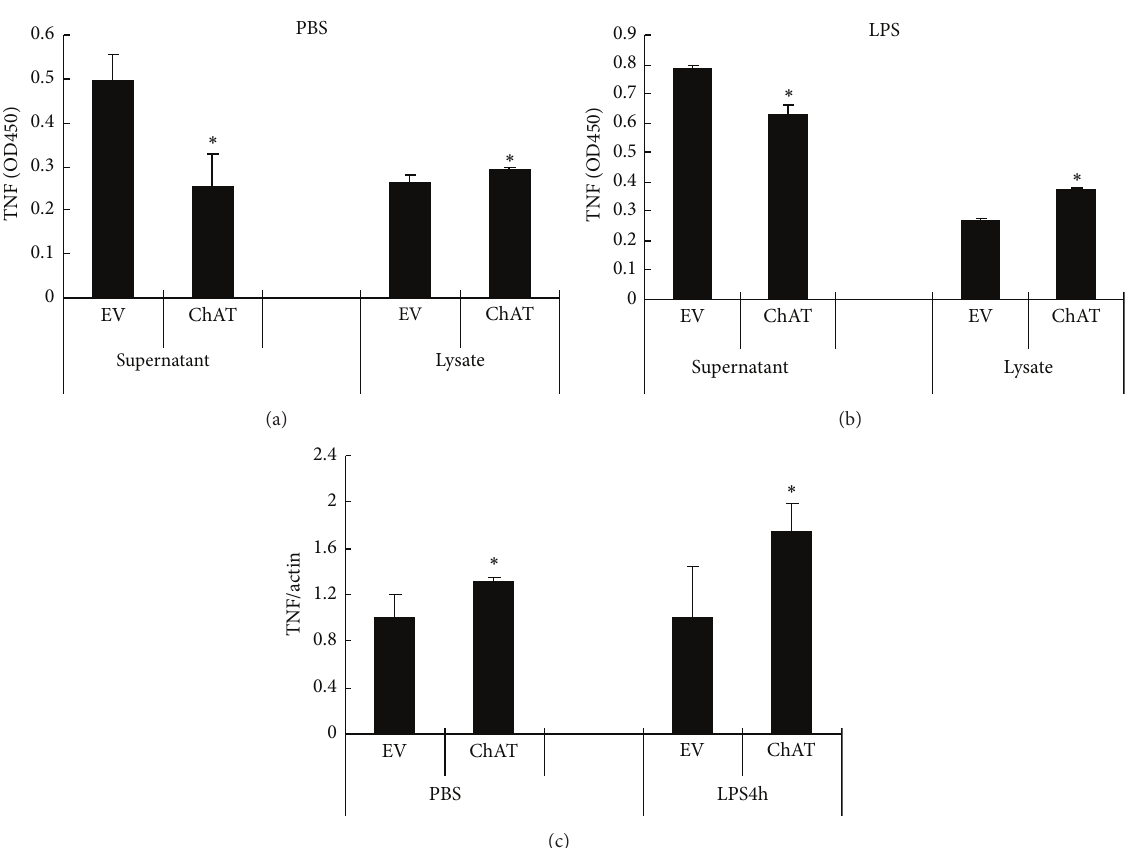
Figure 5: TNF protein and mRNA expression levels in empty vector (EV) and ChAT expression vector (ChAT) infected RAW264.7 cells. TNF content in supernatant and in lysates of empty vector and ChAT expression vector infected RAW264.7 cells following incubation for 4 h: (a) untreated cells (PBS instead of LPS). (b) LPS treated cells. Compared with empty vector infected cells, TNF content in the supernatant decreased and in the lysate was increased in ChAT overexpressed RAW264.7cells. The amount of TNF both in supernatant and in lysate was detected by ELISA and shown as OD450. (c) TNF mRNA expression level in ChAT gene transfected RAW264.7 cells was higher than that in empty vector transfected RAW264.7 cells, both in LPS treated and untreated cells. TNF mRNA expression level was determined by real-time PCR. 𝛽 -Actin was used as the control gene. The data shown are representative of three independent experiments and presented as mean ± SD ( 𝑛 = 3 ). ∗ 𝑃 < 0.05 when compared with EV